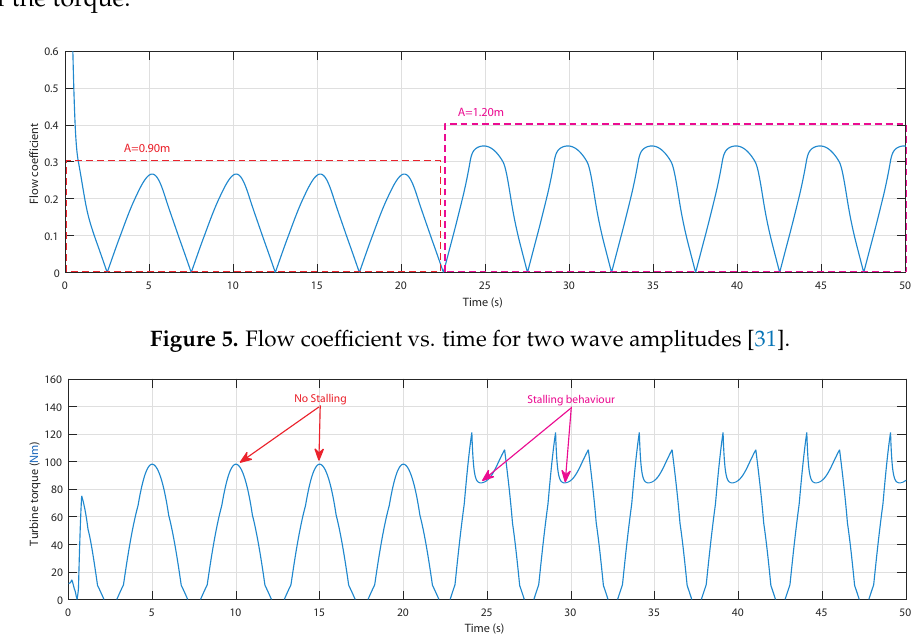
Figure 6. Turbine torques vs. time for two sea conditions